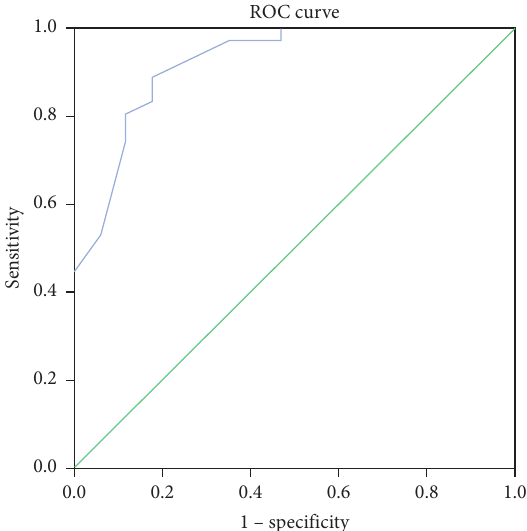
Figure 3: The ROC curve of mPAP (mean pulmonary artery pressure) measured by pulmonary blood flow studies to predict VSD closure ( p < 0 . 001; area under the curve � 0.922, 95% confi- dence interval 0.845–1.000, maximum Youden’s index �